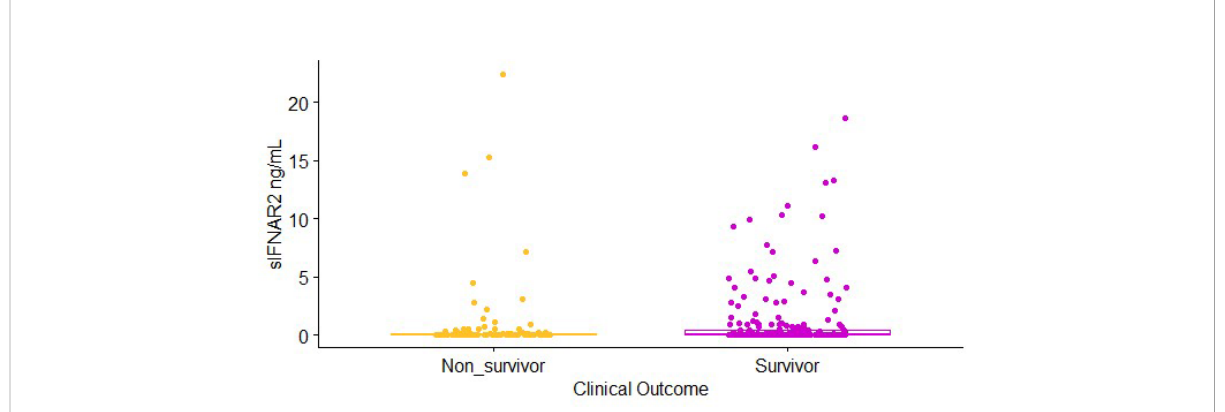
FIGURE 1 Soluble IFNAR2 (sIFNAR2) plasma levels of severe COVID-19 patients (n = 347) divided into non-survivor (n = 108, yellow dots) and survivor (n = 239, purple dots). sIFNAR2 level was evaluated by ELISA. Statistical comparison was performed using Mann-Whitney U Test, p <